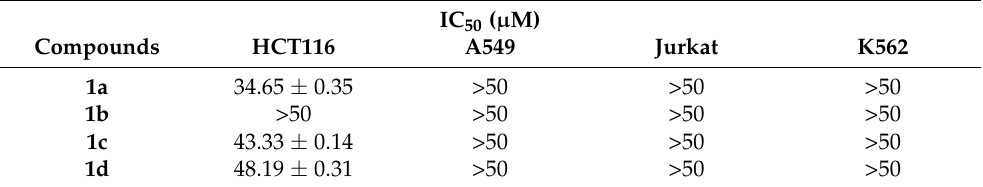
Table 1. Anticancer activities of azo compounds ( 1a – d